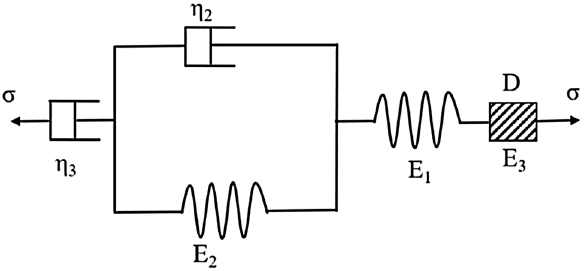
Figure 3. Burgers damage creep model of the elastic damage element combined in